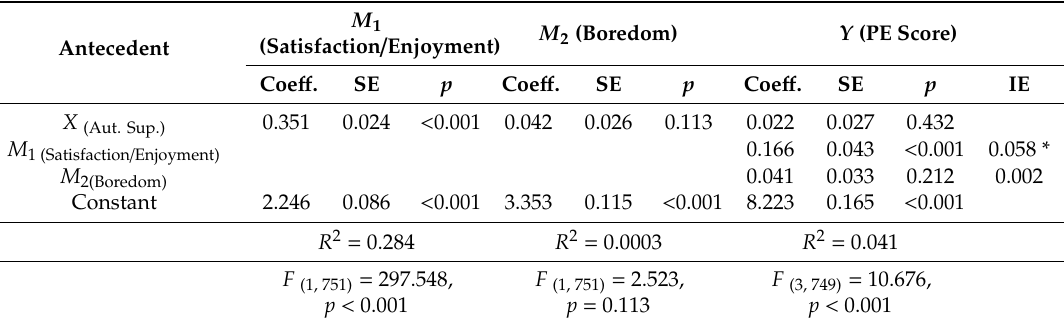
Table 5. Regression coe ffi cients, standard errors, and model summary information for the mediational e ff ects of satisfaction / enjoyment and boredom in the relationship between autonomy support and PE score.